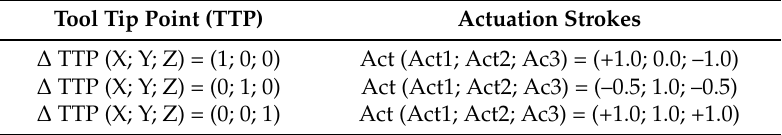
Table 1. Kinematic correlation between displacement at the tool tip point and actuation strokes.